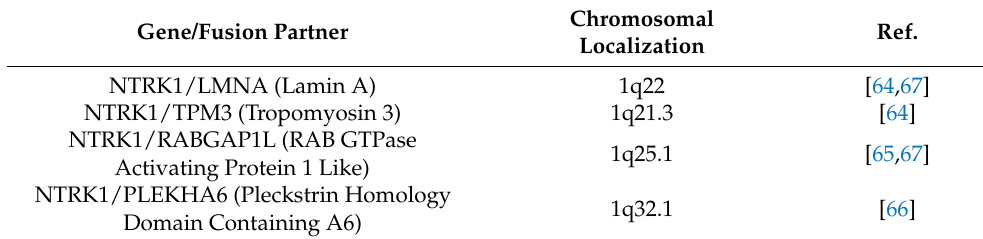
Table 2. NTRK gene fusions identified in